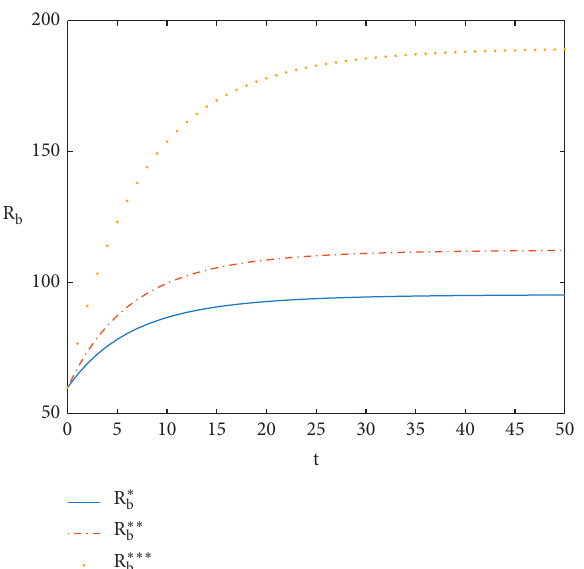
Figure 2: The environmental pollution control level of Local-gov B.